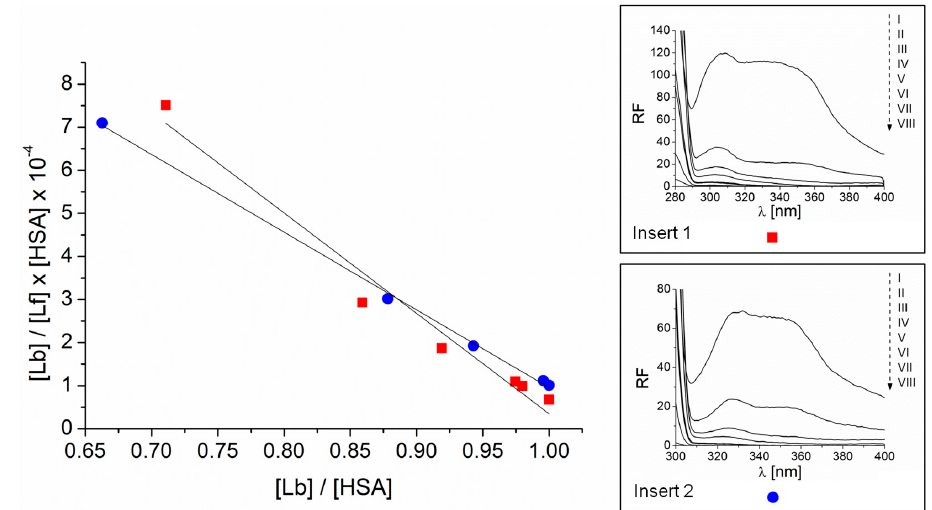
Figure4. Scatchard dependence for the PpIX-HSA complex excited at 280 nm ( ■ ) ( y = − 23.317 x + 23.663) and 295 nm ( ● ) ( y = − 18.44 x + 18.999). Data determined from emission fluorescence spectra.